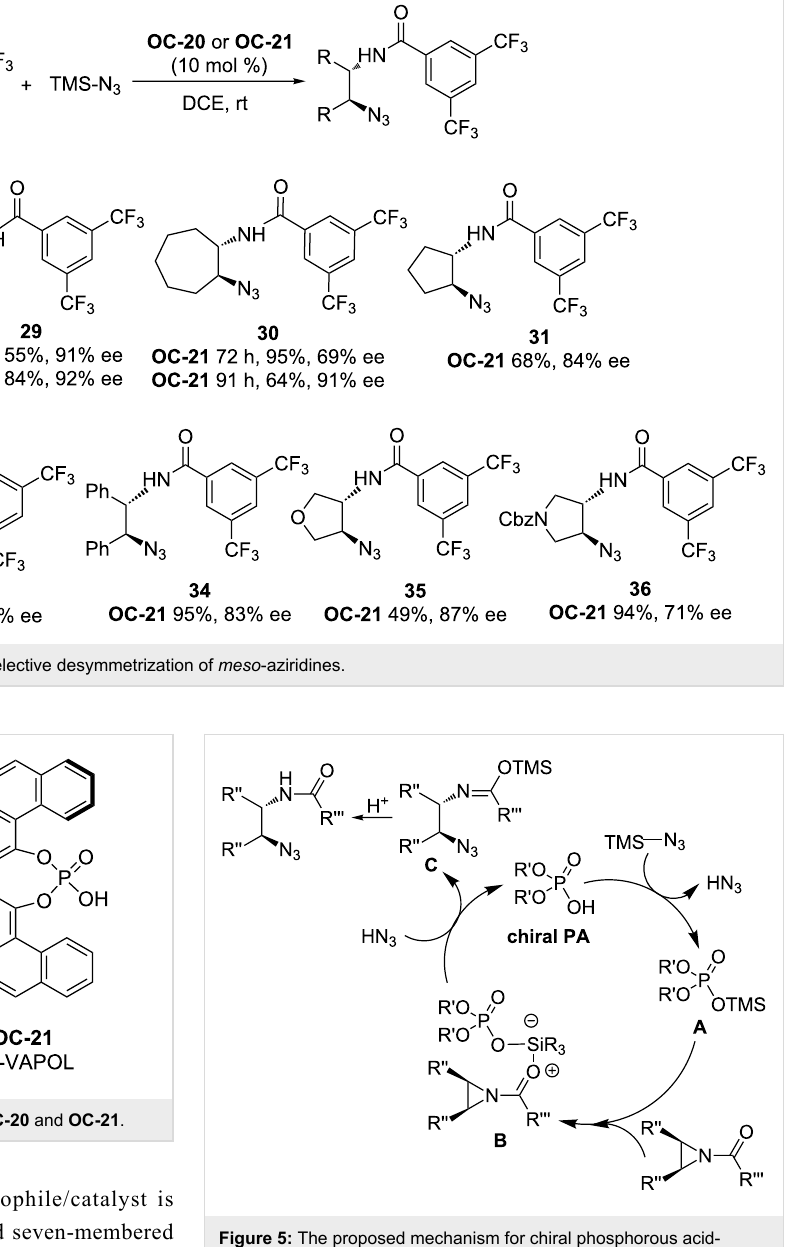
induced enantioselctive desymmetrization of meso -aziridines ( chiral PA = OC-21